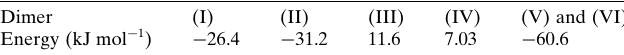
Table 4 Electrostatic energies of various Cl (cid:2)(cid:2)(cid:2) Cl intermolecular interactions of selected molecular dimers (kJ mol (cid:6) 1 ) in OCN.